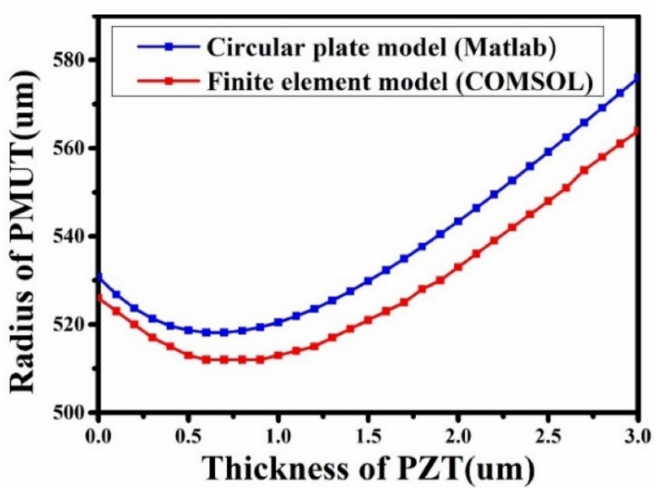
Figure 4. Simulated pMUT radius versus PZT thickness to achieve a 40 kHz resonance frequency.